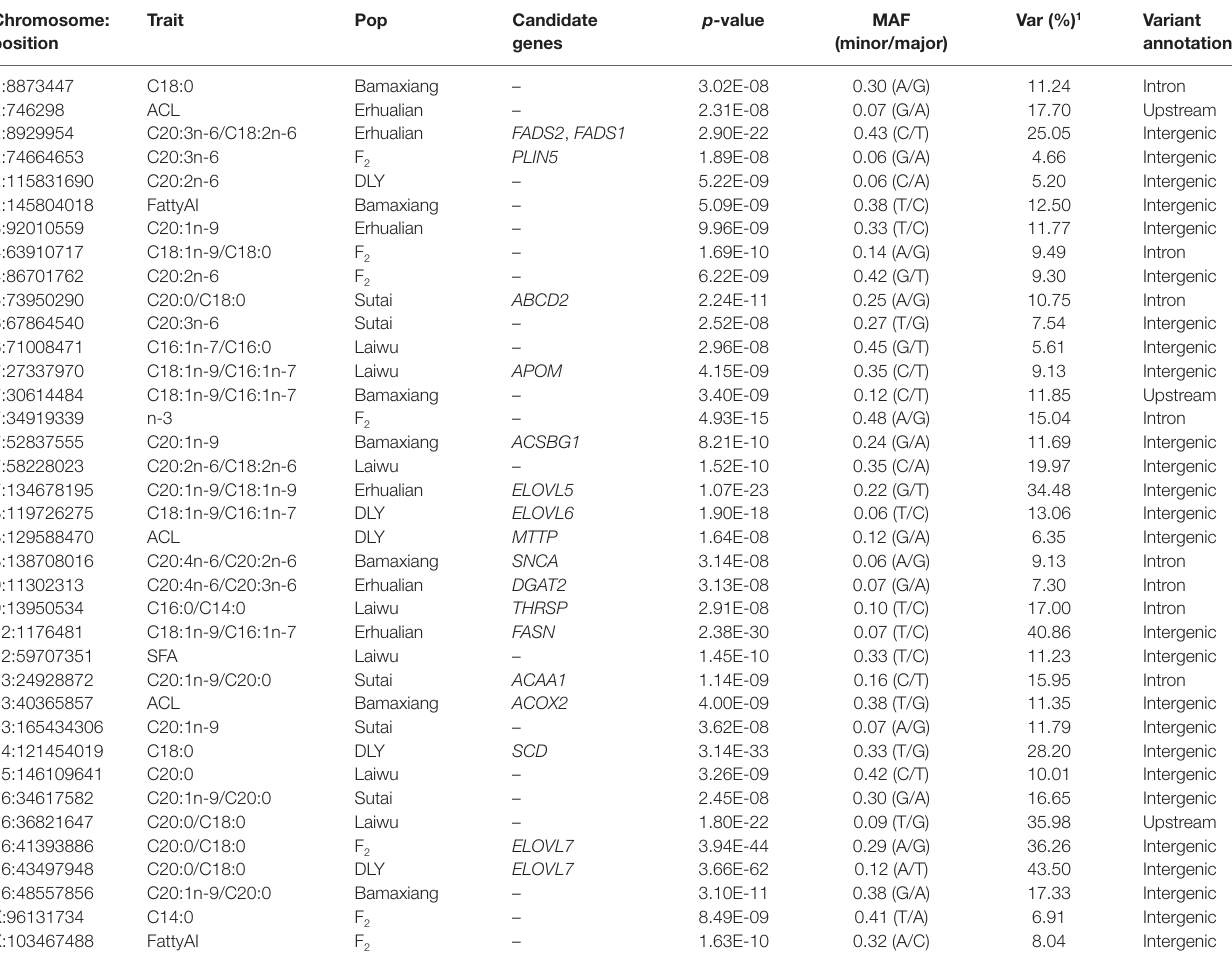
TABLe 1 | Summary of a selection of sentinel lead SNPs for fatty acid composition and metabolism traits in six pig populations by chromosome regions. Chromosome: Trait Pop Candidate position